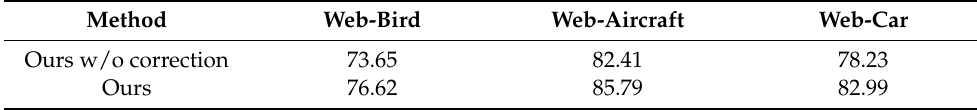
Figure 3. Example of prediction with GRML and MoPro for randomly selected Non-OOD, OOD and noisy label samples in each of the three datasets. Where “Real” represents whether the sample is actually OOD or not, “GRML” and “MoPro” indicate predicted or label corrected results. Table 4. Noiselabel processing performance